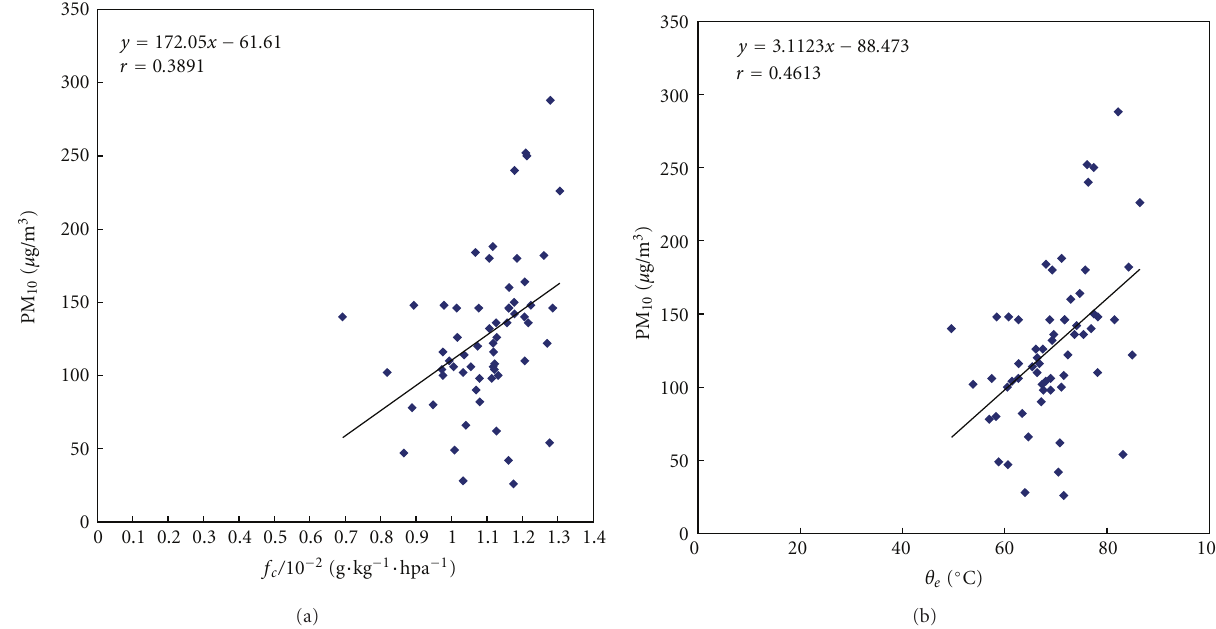
Figure 2: Correlation of PM 10 with f c (a) and θ e (b) for July–August